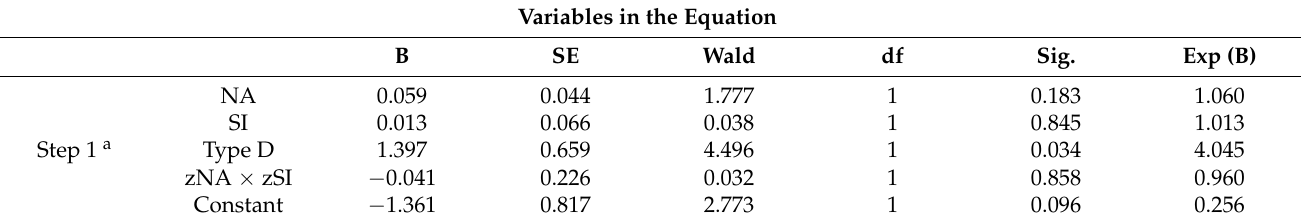
Table 5. Association of the expressed preference for the escape–avoidance strategy according to the questionnaire WSQ with the components of personality type D (binary logistic regression analysis, enter method).